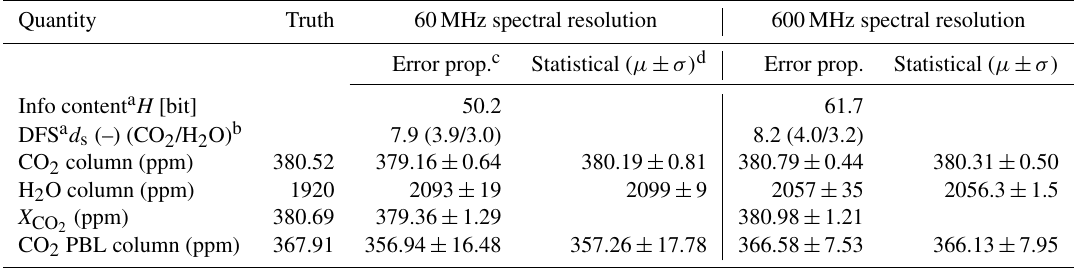
Table 1. Summary of column measurements and errors from the OSS. Values under the error propagation header correspond to the first ensemble member. The planetary boundary layer (PBL) column is here defined as between 0 and